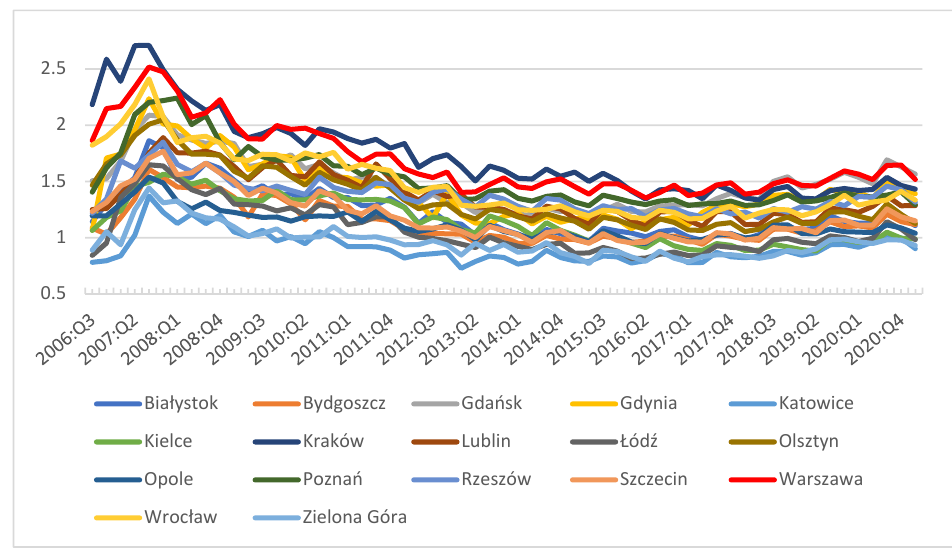
Figure 3. Price-to-income ratio—17 Polish cities.